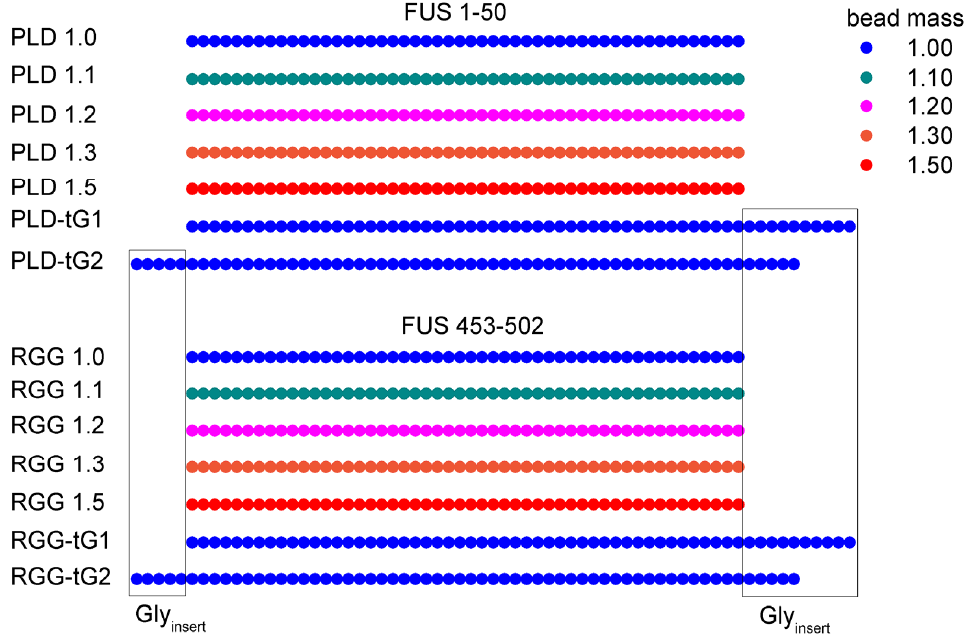
Figure 1. The schematic diagram of different FUS chain models. The different colors represent dif- ferent bead masses. The beads within rectangle area represent inserted glycine residues.